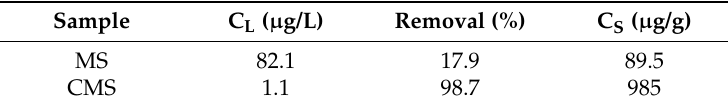
Table 2. Comparison of Cd 2+ removal by MS and CMS.